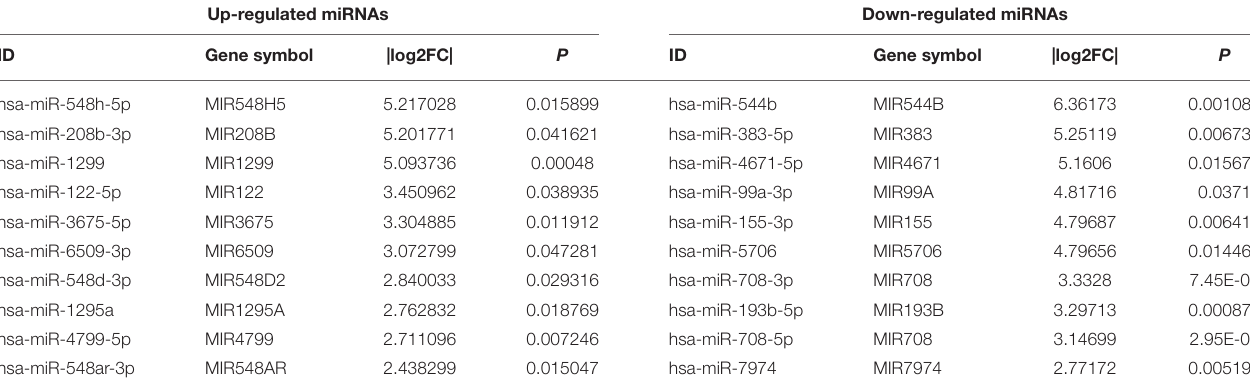
TABLE 4 | Top 10 of differently expressed miRNAs in HT and non-HT